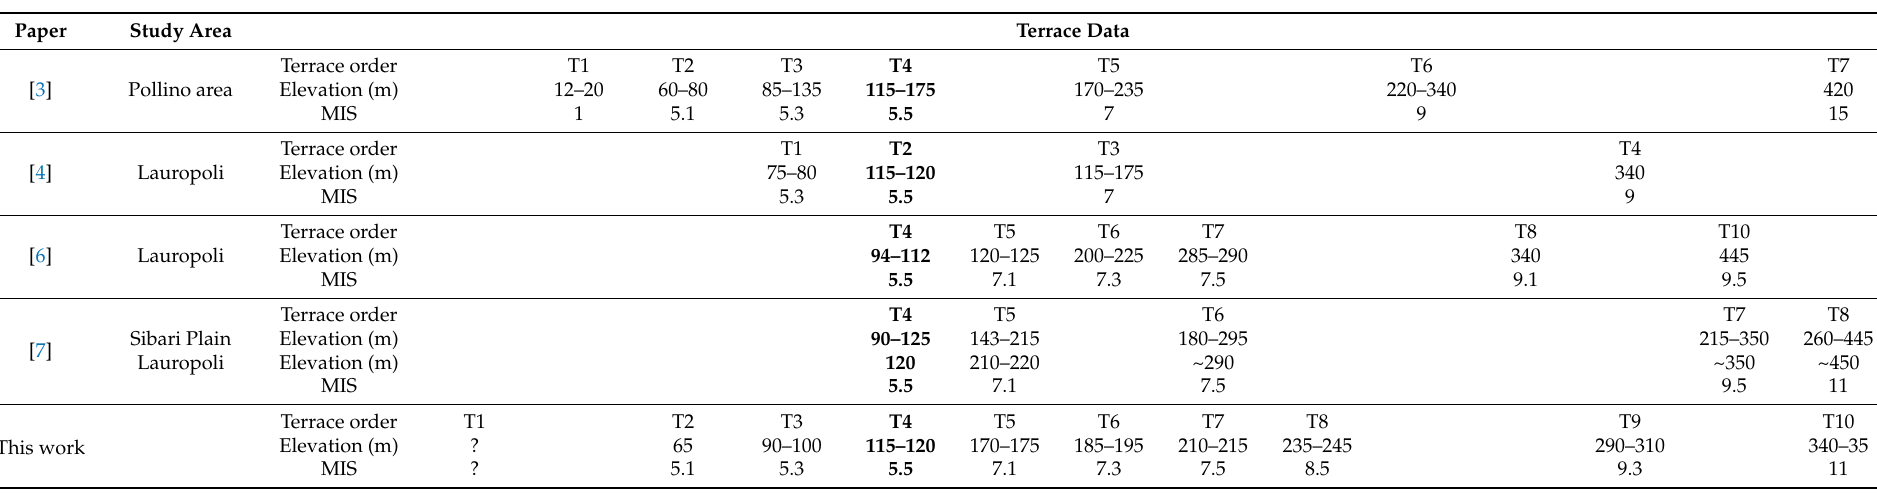
Table 1. Synoptic table of marine terrace chronology in northeastern Calabria based on a critical review of all available dating. For each work, the study area, terrace order, elevation range, and corresponding Marine Isotope Sage (MIS) are listed. Data related to MIS 5.5 are shown in